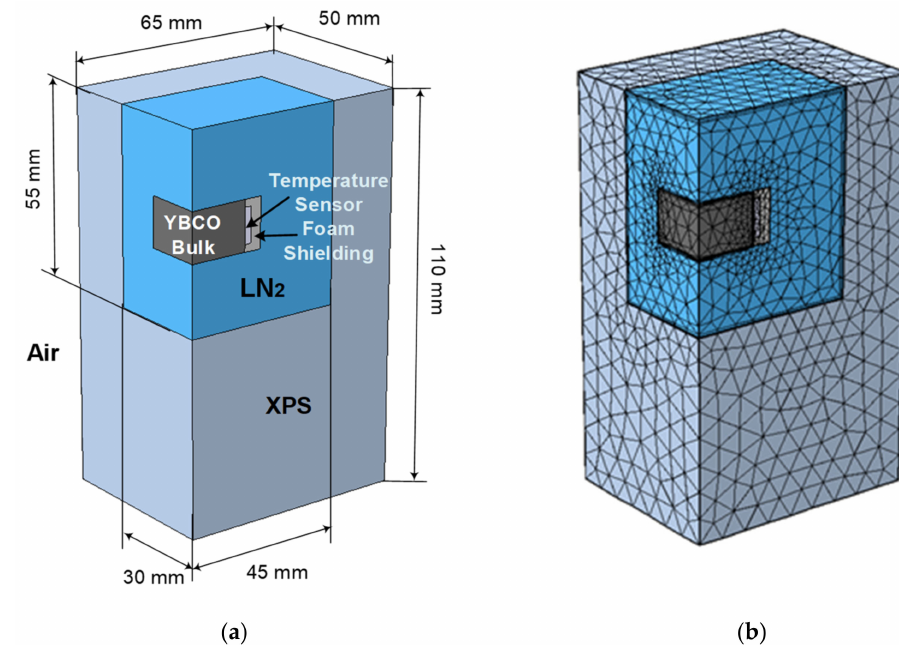
Figure 5. Design with dimensions of one box quarter ( a ) and mesh in 3D FEA ( b